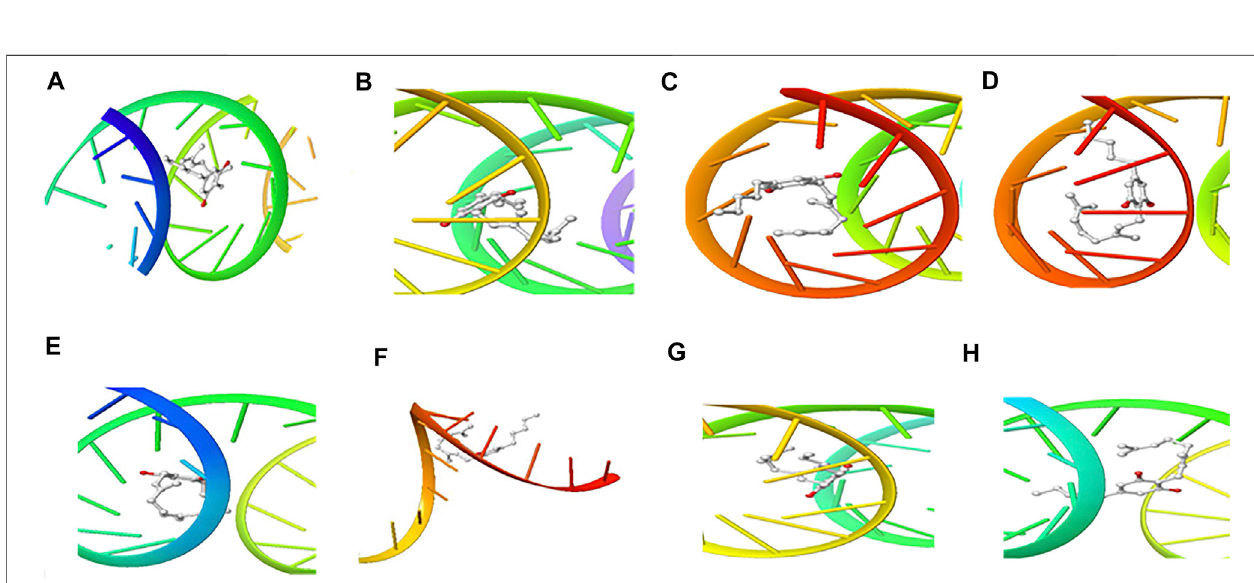
FIGURE 7 | 3D Interaction of Cannabigerol with Initiation and Termination Sequence of the Viral Proteins. A (cid:1) Nucleocapsid Phosphoprotein Translation Initiation Site;B (cid:1) EnvelopeProteinTranslationInitiationSite;C (cid:1) EnvelopeProteinTranslationTerminationSite;D (cid:1) NucleocapsidPhosphoproteinTranslationTerminationSite; E (cid:1) ORF1ab Translation Initiation Site; F (cid:1) ORF1ab Translation Termination Site; G (cid:1) Surface Glycoprotein Translation Termination Site; H (cid:1) Surface Glycoprotein Translation Initiation